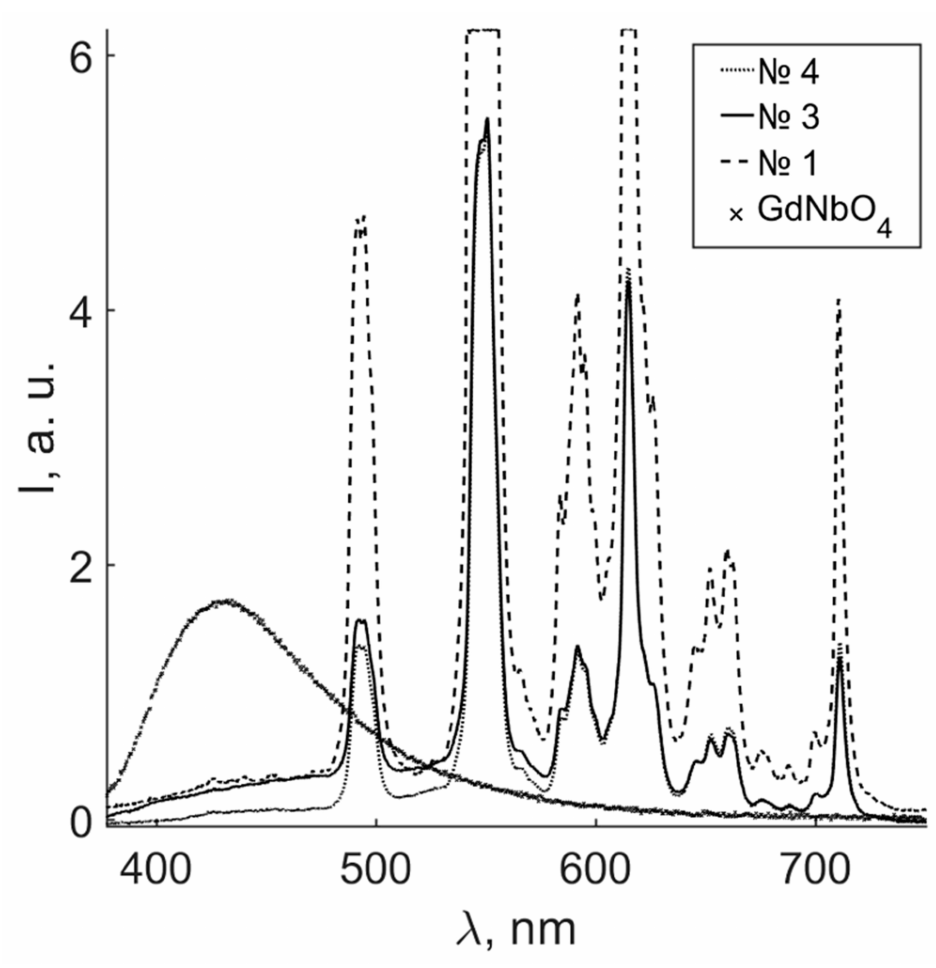
Figure 5. Photoluminescence spectra of samples 1, 3, 4, and a GdNbO 4 ceramic. The intensity of luminescence of Gd 0.96 Eu 0.01 Sm 0.01 Tb 0.01 Er 0.01 Nb 0.9 Ta. 0.1 O 4